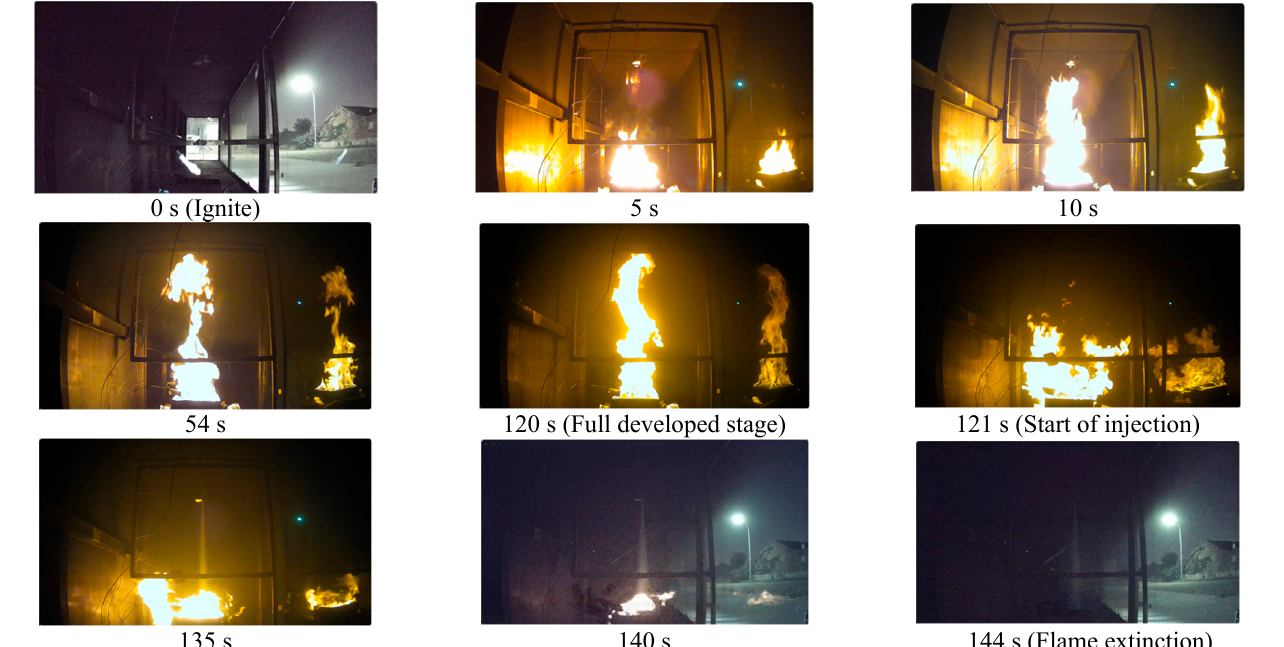
Figure 2. Changes in the characteristics and form of the fire under test condition 2.